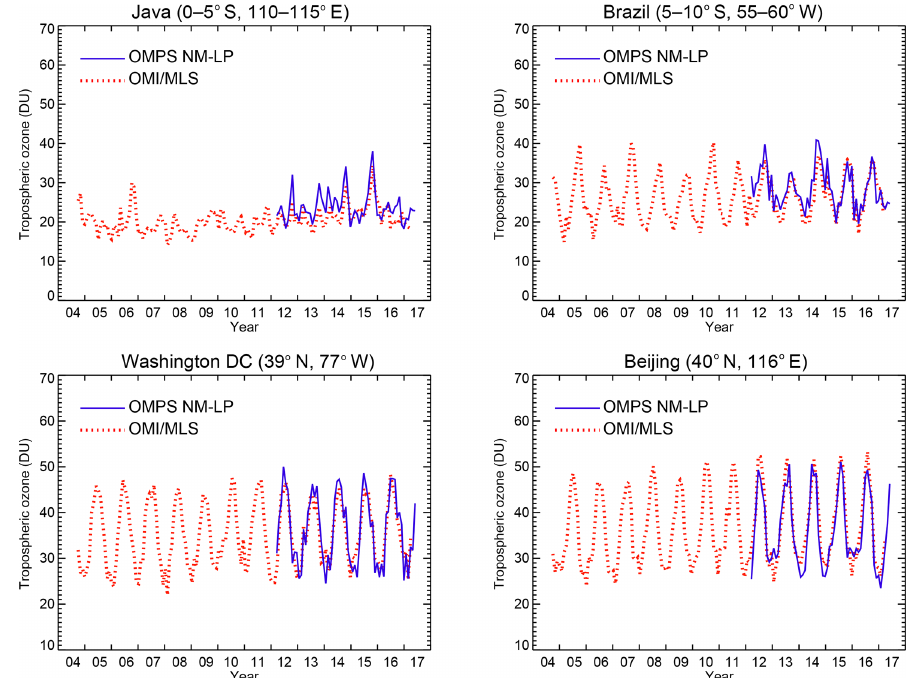
Figure 12. The time series of tropospheric ozone shown for four locations. Tropospheric ozone derived by subtracting OMPS LP stratospheric ozone from NM total column ozone is shown in the blue solid curve, while tropospheric ozone derived by subtracting MLS stratospheric ozone from OMI total column ozone is shown in the dashed red